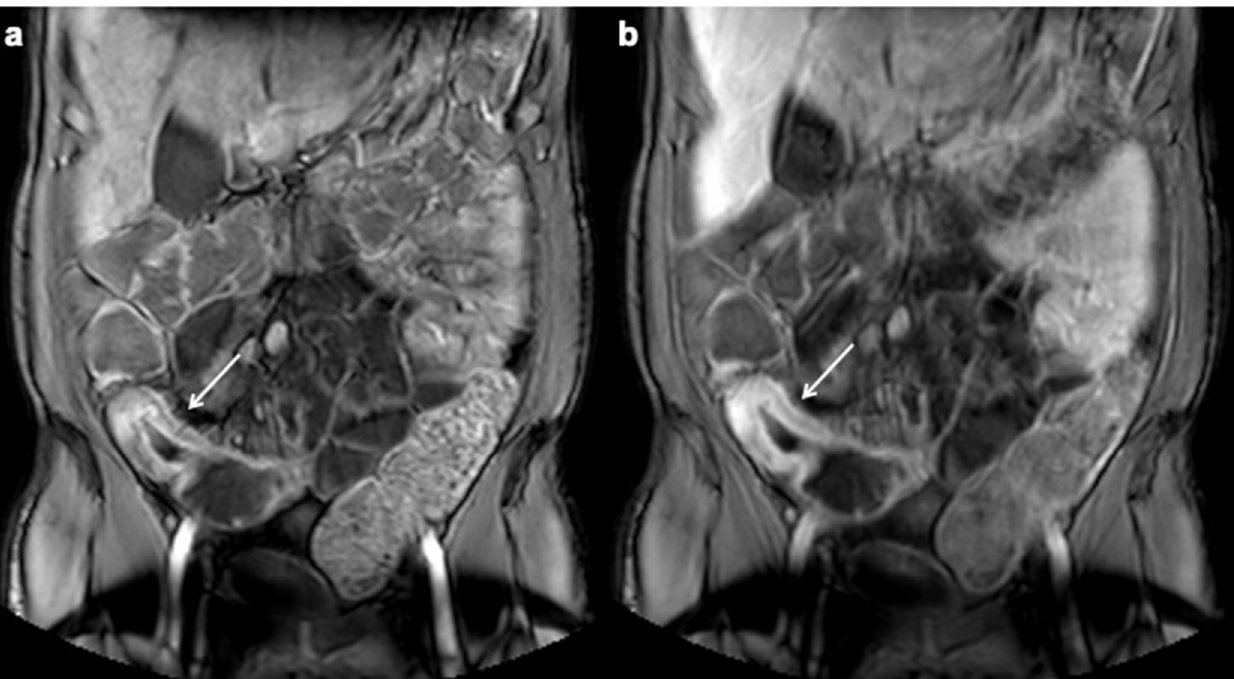
Figure 1. Segmental mural hyperenhancement. Coronal contrast enhanced T1-weighted MRE images in the enteric ( a ) and portal venous ( b ) phases show small bowel wall thickening with trilaminar mural hyperenhancement (white arrows), findings consistent with active inflammatory CD.